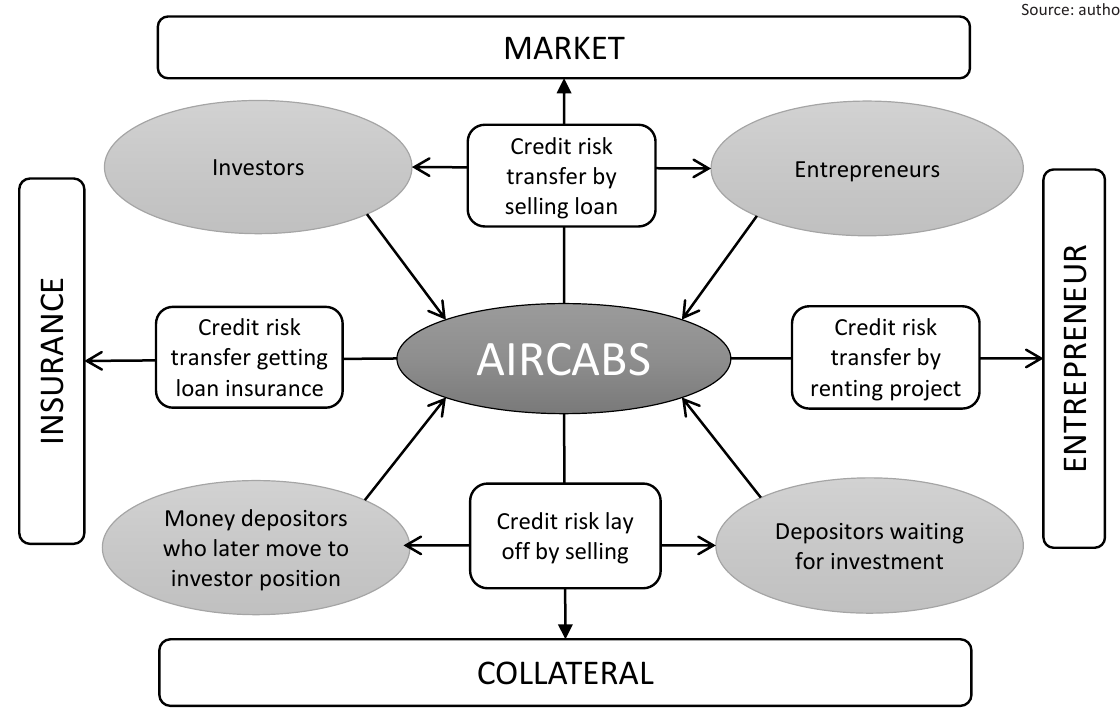
Figure 1. AIRCABS risk transfer